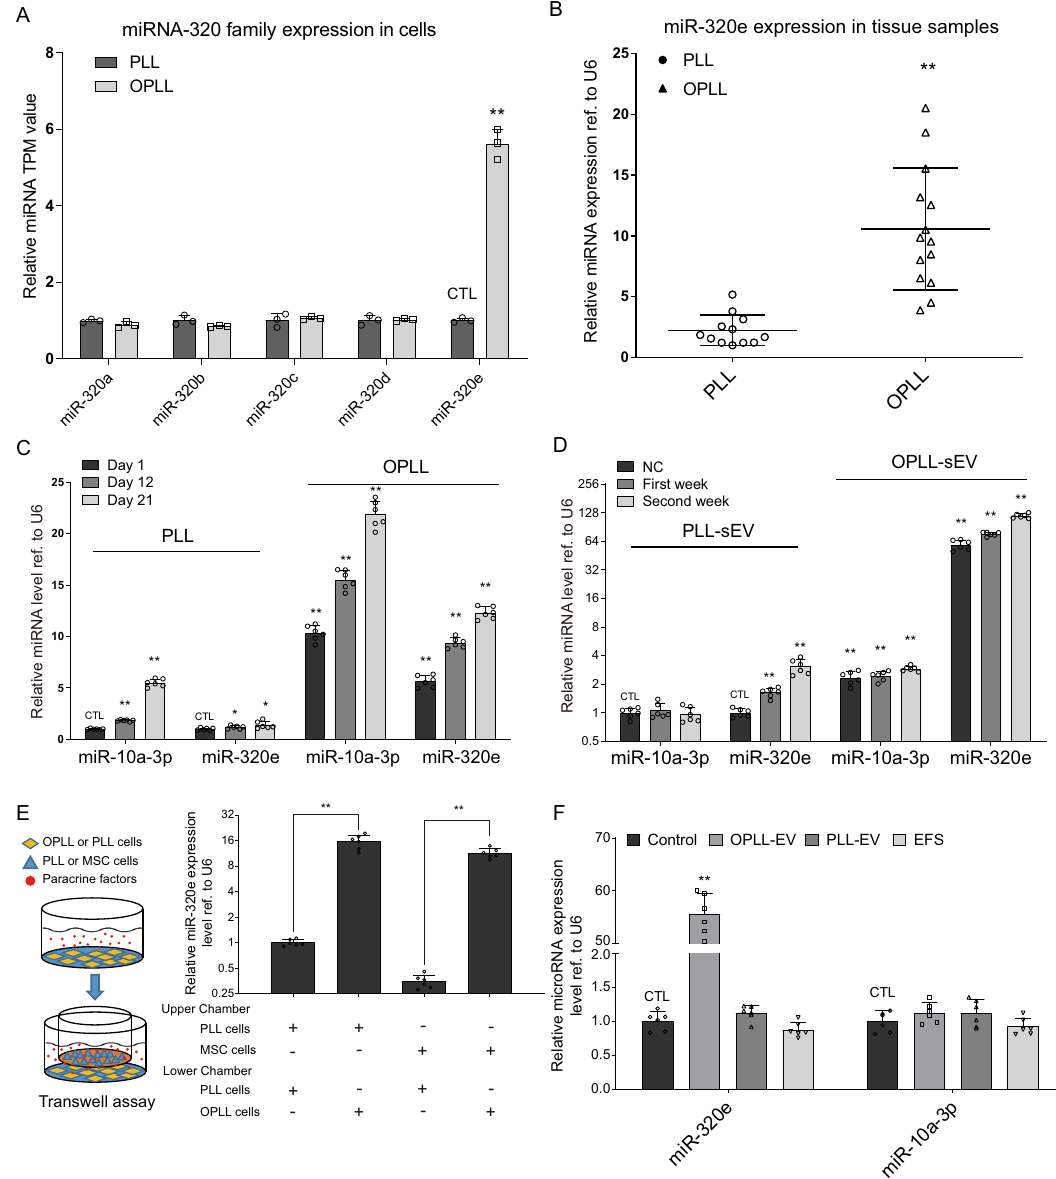
Fig. 3 miR-320e is highly expressed in OPLL-sEV and upregulated in OPLL. A Comparison of the miRNA expression levels of miR-320 family in OPLL and PLL cell derived from High through-put sequencing data ( n = 3, two tailed t test). TPM represents transcripts per kilobase million in the sequencing data. B qRT-PCR analysis detecting the expression level of miR-320e in OPLL ( n = 14) and PLL ( n = 12) tissues (two tailed t test). C qRT-PCR analysis detecting the expression level of miR-320e in osteogenic induced OPLL and PLL cells at different time point. Data showing respective microRNA expression fold changes compared to that of non-induced PLL cells (day 1) were presented ( n = 6, two tailed t test). D qRT-PCR analysis detecting the expression level of miR-320e in osteogenic induced OPLL and PLL cell derived sEVs at different time point. Data showing respective microRNA expression fold changes compared to that of non-induced PLL cells derived sEV (NC) were presented ( n = 6, two tailed t test). E Transwell assay followed by qRT-PCR analysis detecting the expression level of miR-320e in the co-cultured MSC or PLL cells ( n = 6, two tailed t test). F qRT-PCR analysis detecting the expression level of miR-320e in sEV or EFS treated PLL cells ( n = 6, two tailed t test). EFS represents with the supernatant of sEV collection that is free of sEVs. U6 level were detected and served as internal reference. All data were presented as the mean ± SD. * p < 0.05, ** p < 0.01. Detailed statistical data and source data are provided in a Source Data fi